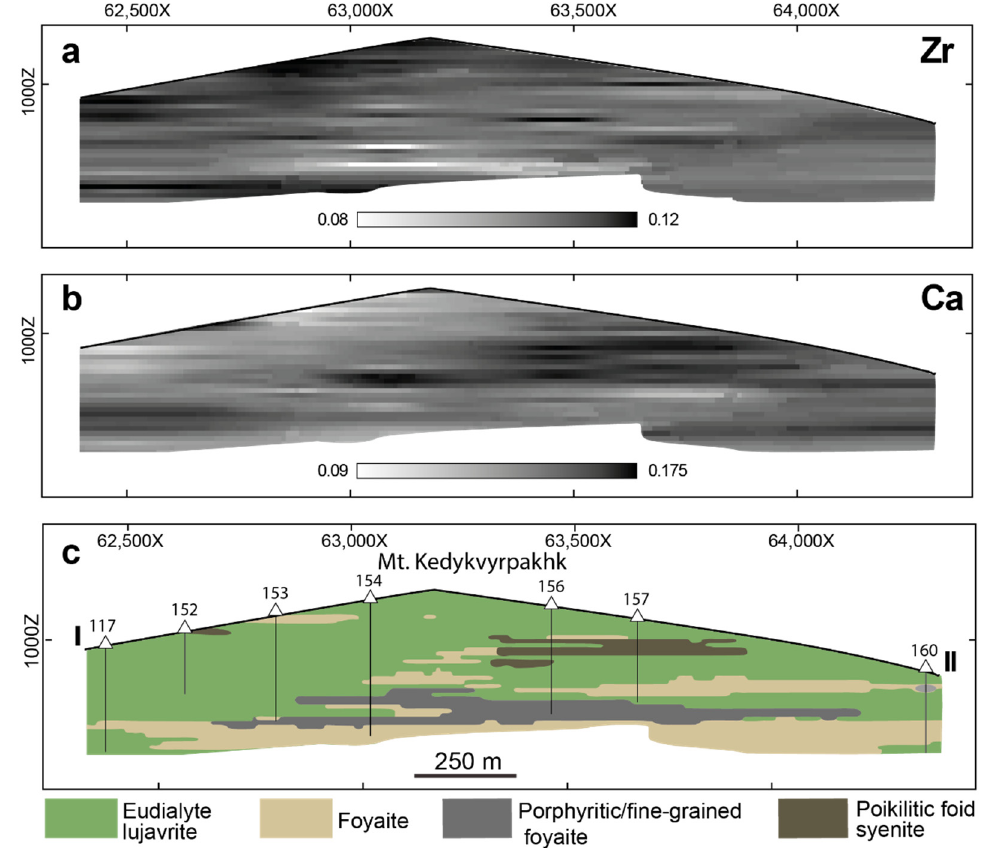
Figure 9. The section along the I–II line of Mt. Kedykvyrpakhk, Lovozero massif: ( a ) distribution of Zr (atomic amount) in EGM, ( b ) distribution of Ca (atomic amount) in EGM, ( c ) geology and drill holes. The cross-section was extracted from 3D block models generated by Micromine 2016.1. Interpolation was carried out by an inverse distance weighted method. The meaning units for X and Z axis are given in meters.